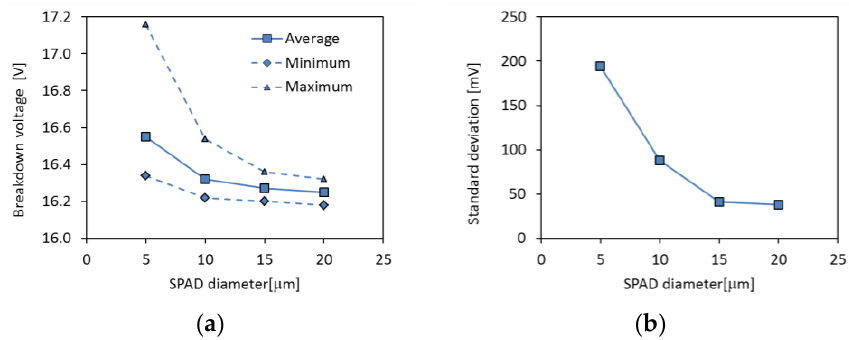
Figure 4. Measured breakdown voltage as a function of SPAD diameter. Measurements were done on 150-nm CMOS SPADs [27]. ( a ) Breakdown voltage distribution; ( b ) breakdown voltage non-uniformity (standard deviation).